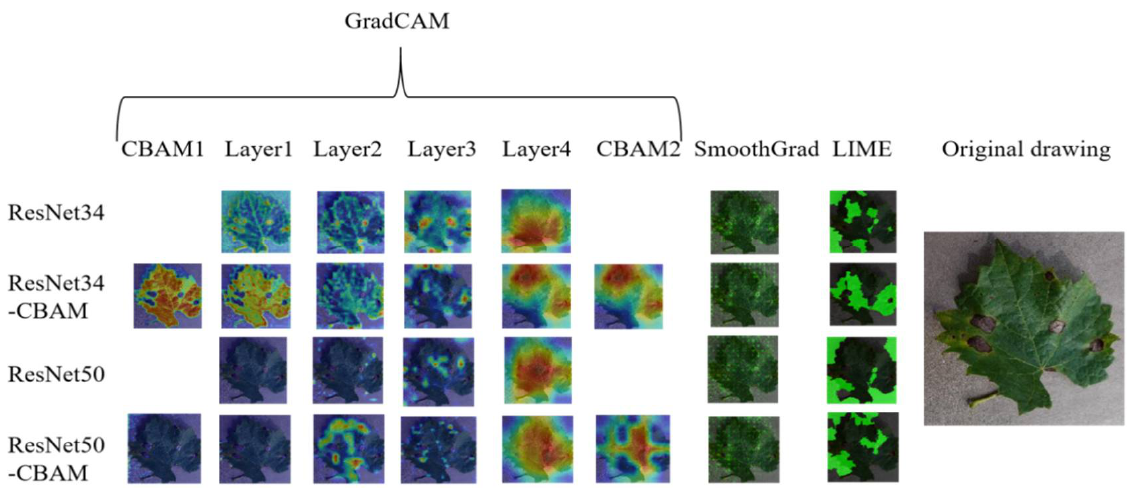
Figure 4. Visualization results of Experiment I. Each row represents the visualization result diagram of one model, and the column represents the effect diagram of GradCAM (including CBAM1, Layer1–4, and CBAM2 each layer result diagram. Layer1–4 corresponds to the four convolutional layers of random ResBlock in Figure 3), SmoothGrad, LIME, and the original